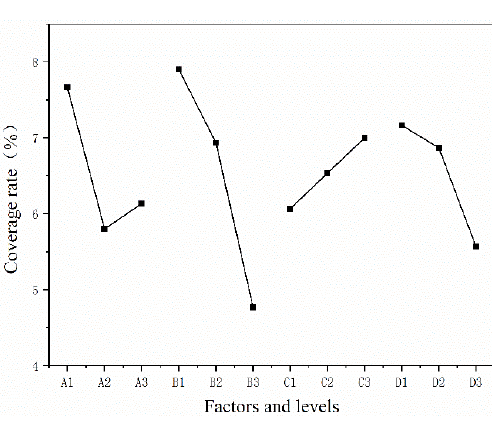
Figure 2. The visual analysis chart. Table 10. Analysis table of variance.